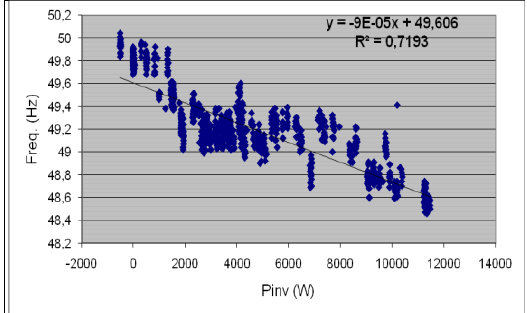
Figure 12. The battery inverters´ f-P droop curve for a 2-hr load profile.